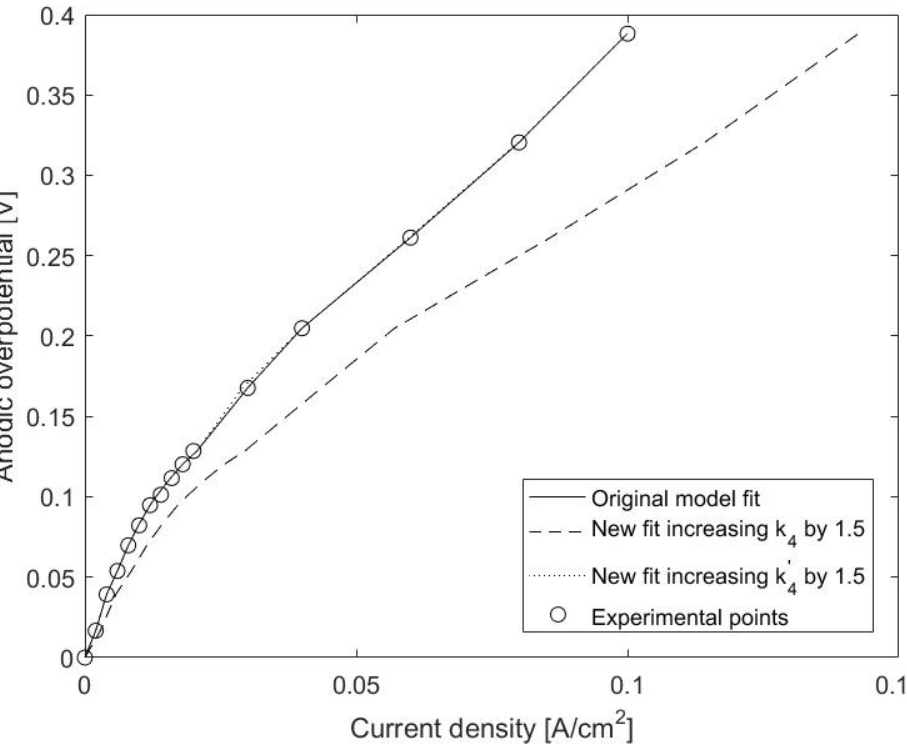
Figure 3. Effect of most sensitive parameters on polarization curve for PtSn 3 .